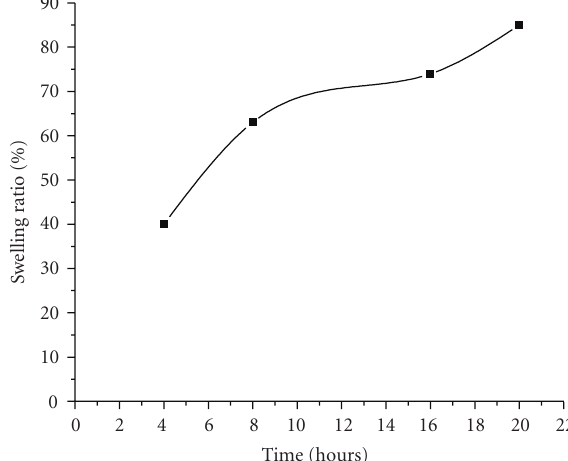
Figure 9: Swelling percentage of (IPP-g-MMA) as function of time.